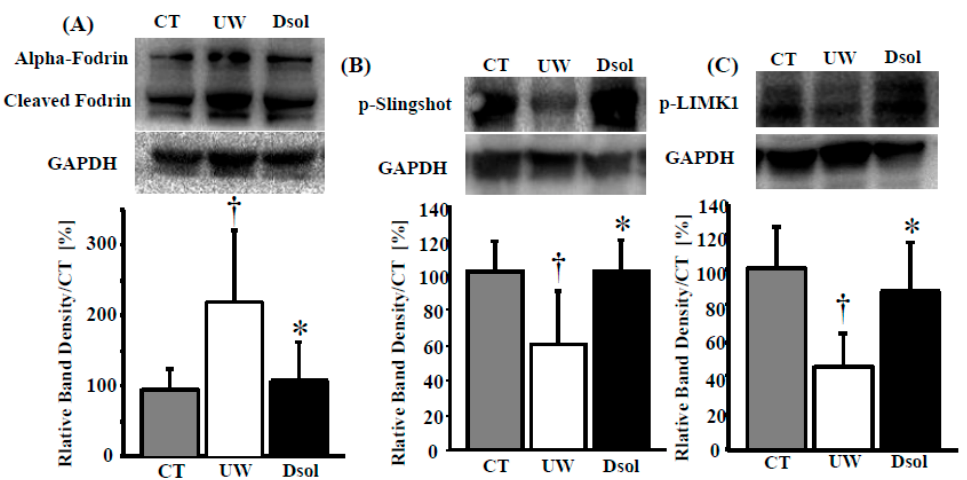
Figure 5. Dsol attenuates cytoskeletal breakdown. Cytosolic protein in the liver was applied to the western blot ( top ), and the relative intensity ( bottom ) was shown. Panels A–C show the results for ( A ) Cleaved alpha-Fodrin, ( B ) phosphorylated Slingshot, ( C ) phosphorylated LIMK1. Relative quantitation of each sample was performed, using Glyceraldehyde 3-phosphate dehydrogenase (GAPDH) as an internal control. Each normalized value was further normalized by the mean value in the CT group, and expressed as the means. * † A p- value less than 0.05 was considered significant: *: UW versus Dsol, † versus CT.